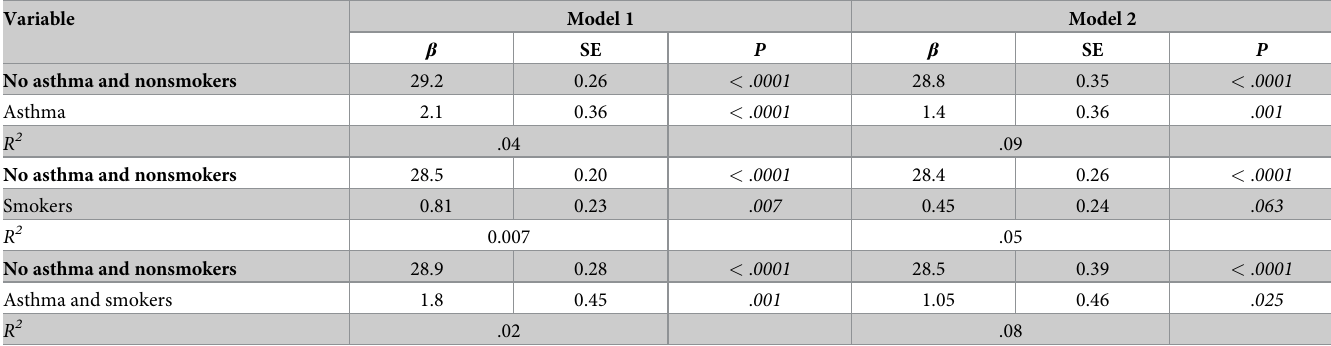
Table 2. Associations of asthma and smoking with body mass